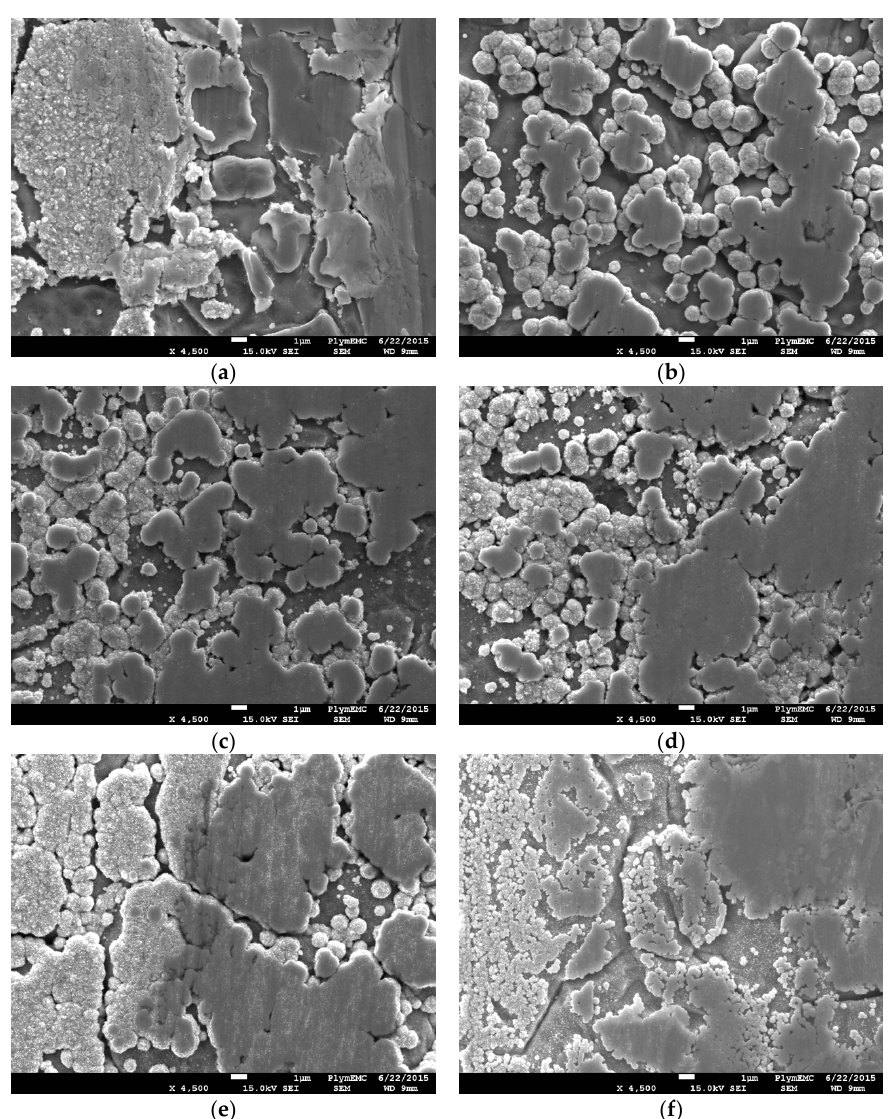
Figure 7. SEM micrographs of wear track borders taken at ×4500 magnification. ( a ) DCP with FC ‐ FC-4:PTFE ratio 1:1; ( b ) PCP with FC-4:PTFE ratio 1:1; ( c ) DCP with FC-4:PTFE ratio 1.5:1; ( d ) PCP with 4:PTFE ratio 1:1; ( b ) PCP with FC ‐ 4:PTFE ratio 1:1; ( c ) DCP with FC ‐ 4:PTFE ratio 1.5:1; ( d ) PCP with FC ‐ 4:PTFE ratio 1.5:1; ( e ) DCP with FC ‐ 4:PTFE ratio 2:1; ( f ) PCP with FC ‐ 4:PTFE ratio 2:1. FC-4:PTFE ratio 1.5:1; ( e ) DCP with FC-4:PTFE ratio 2:1; ( f ) PCP with FC-4:PTFE ratio